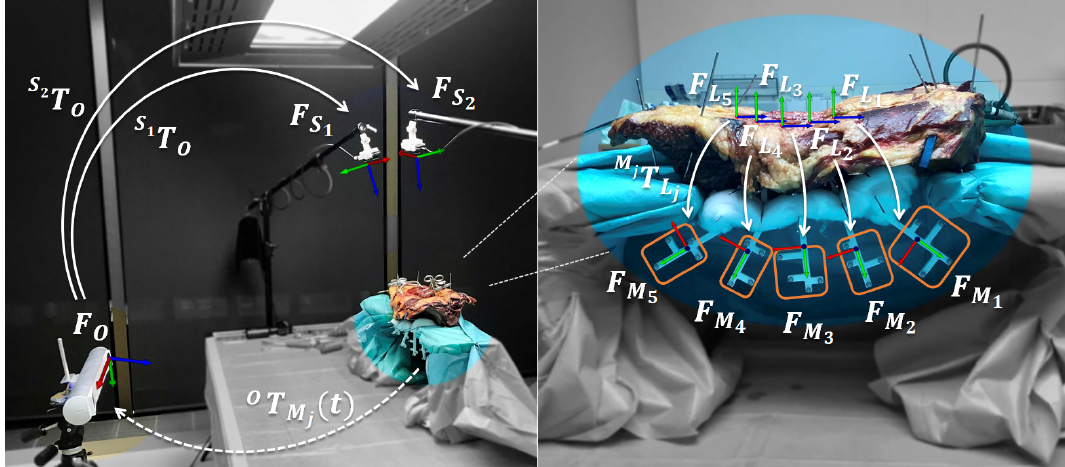
Figure 1. Setup overview with coordinate frames ( F ) and transformations ( T ). Dedicated markers ( F M attached to spine levels L1–L5 ( F L F O ). The surgical site is viewed from the top by two RGB-D sensors ( F S RGB-D sensors ( S 1 T O , S 2 T O ) can be found intraoperatively using the method described in Section 2.3. The relative marker poses w.r.t. the anatomy ( M j T L